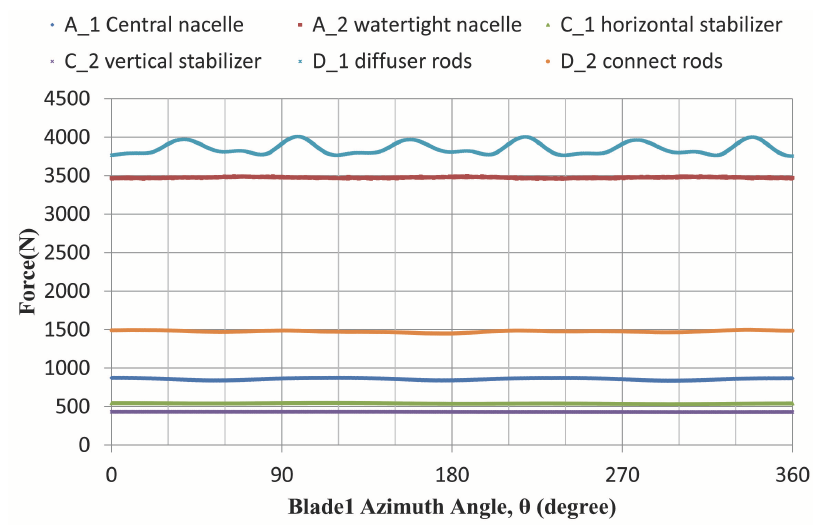
Figure 8. Axial forces imposed on each turbine components vs. the azimuth angle.